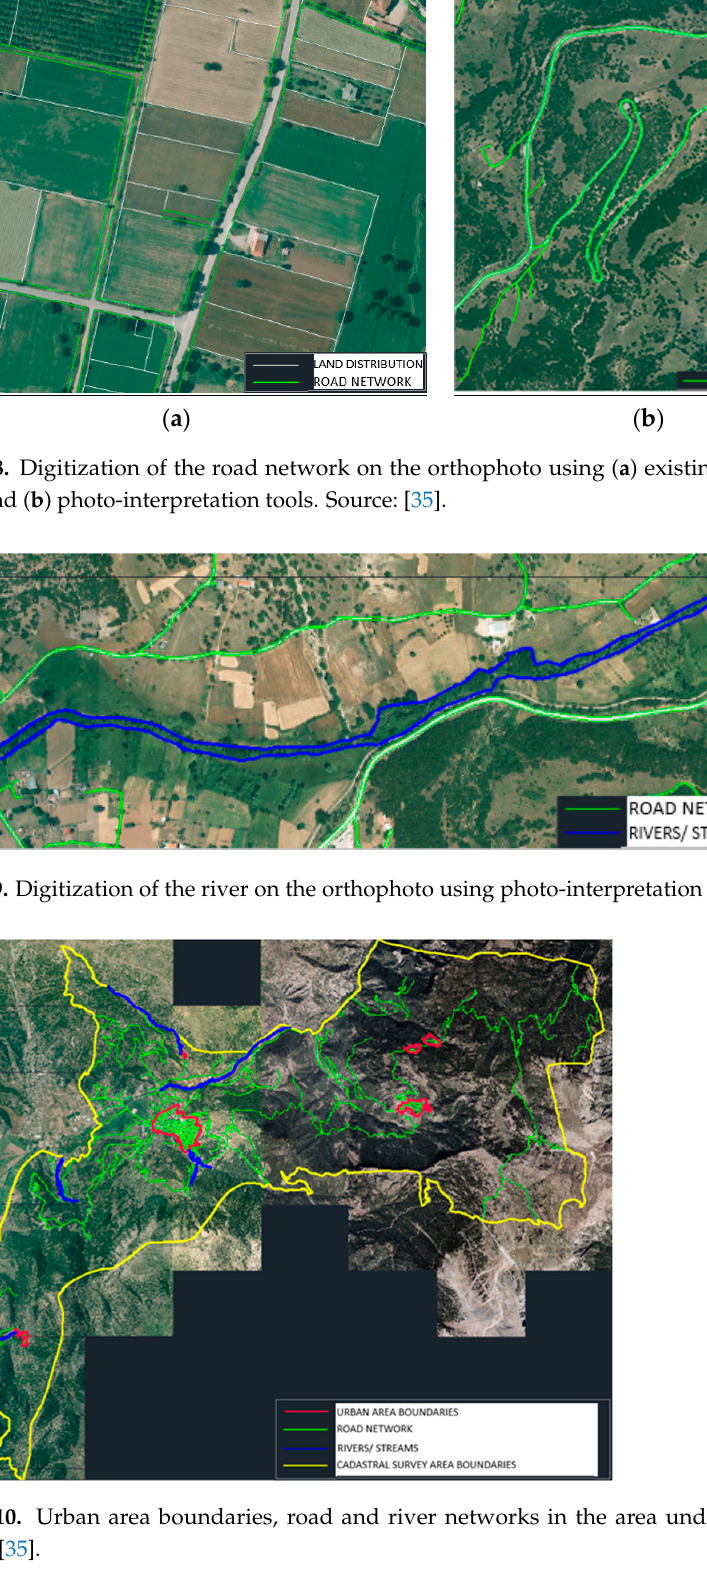
Figure 11. Overlay of the forest maps on the orthophoto. Source: [35]. • Geo-reference and digitization the land parcel boundaries as derived from existing administrative acts on the orthophoto. If there is not such information available, the contractor must digitize the preliminary land parcels based on photo-interpretation tools and with the assistance of local citizens (Figure 12a,b).